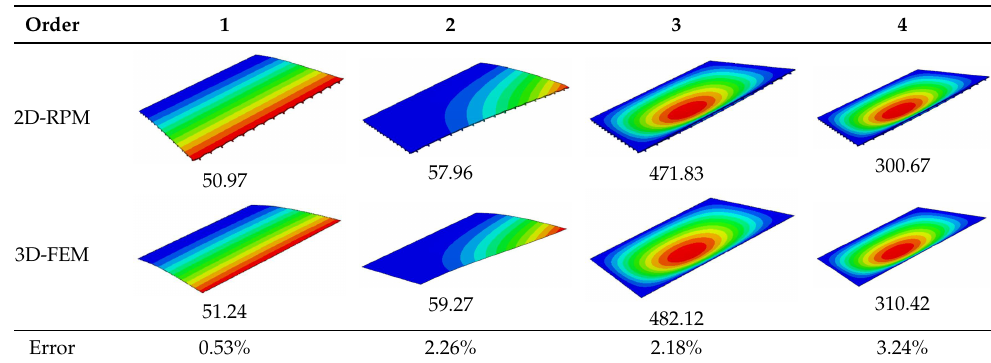
Figure 11. Four combination of boundary and load conditions used in buckling analysis. Table 3. Comparison of global buckling modes and loads (N) predicted by the 2D-RPM and 3D-FEM under different boundary and load